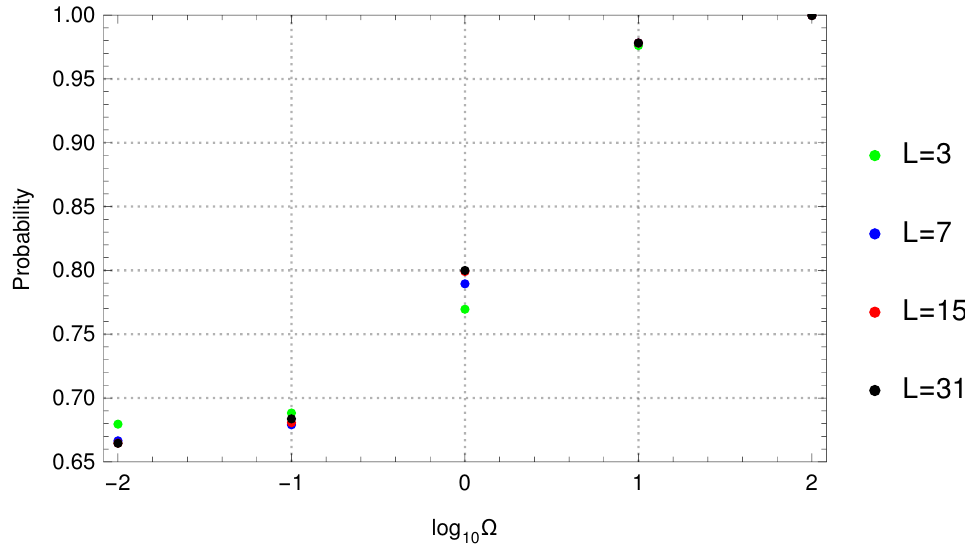
Figure 2. The maximal probability to find an electron in an interval, P max , Equation (2), for different values of opacity, Ω , and for different numbers of units, L , in the model of Kronig and Penney